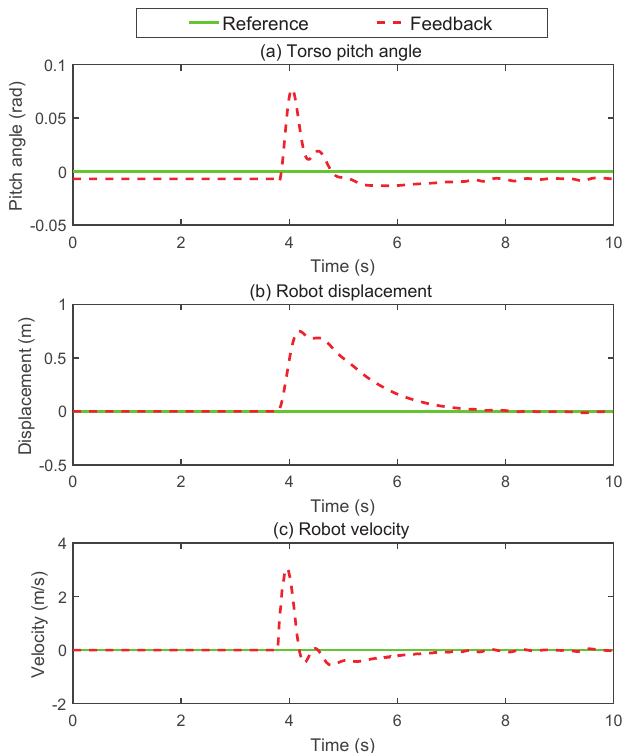
Figure 8. Sagittal plane impact adjustment process curve. ( a ) The measurement of torso pitch angle. ( b ) The displacement curve of the robot. ( c ) The velocity profile of the